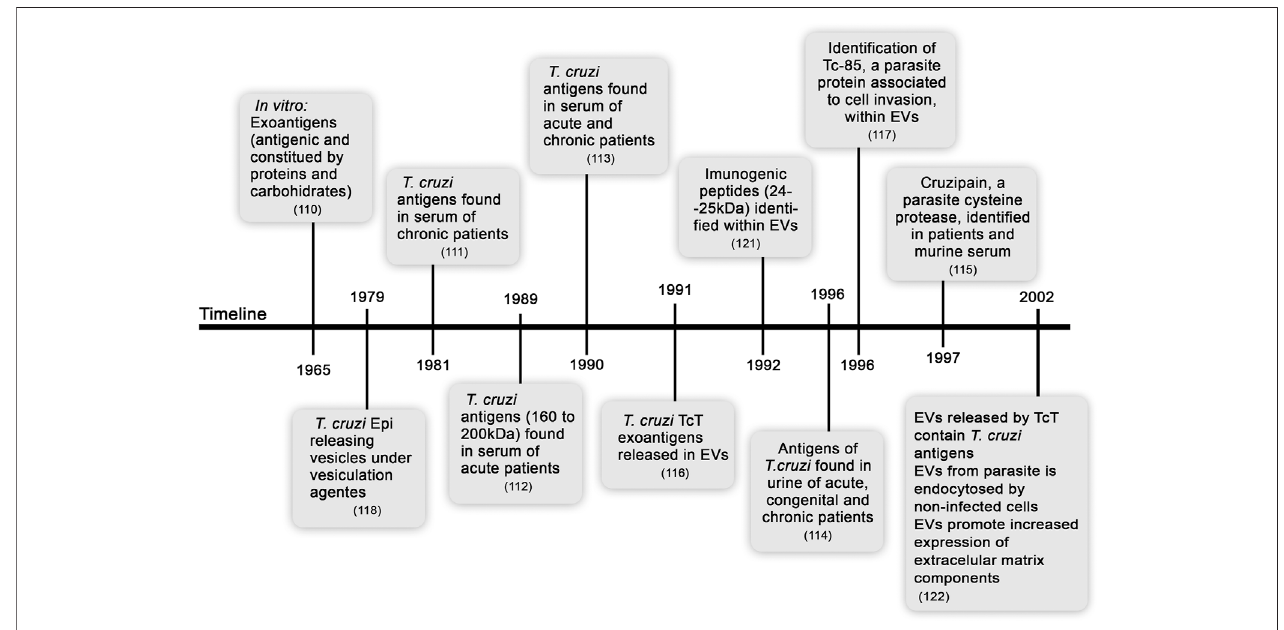
FIGURE 1 | Timeline from the discovery of soluble exoantigens to description of the release of extracellular vesicles by Trypanosoma cruzi.